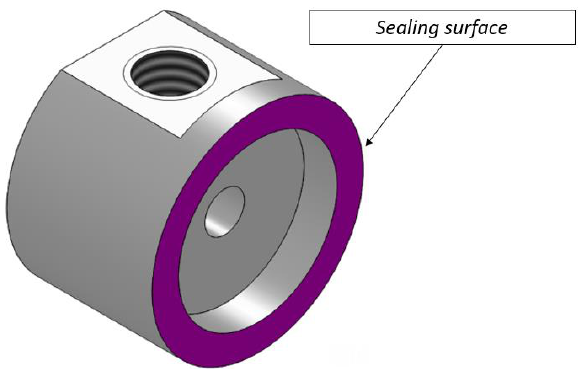
Figure 1. Sealing surface for leak tests.